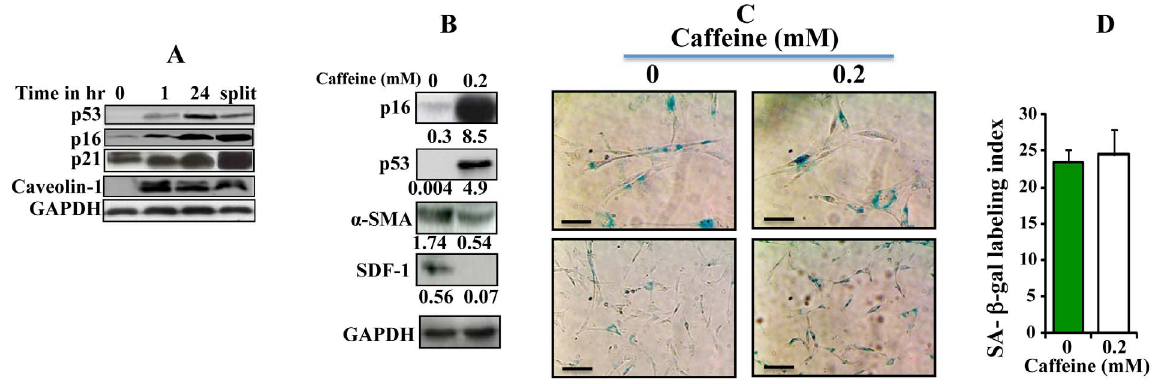
Figure 5. Caffeine effects are persistent. (A) Cells were either sham-treated (0) or challenged with caffeine (0.2 mM, for 1 hr), and then immediately harvested (1) or reincubated in caffeine-free medium for 24 hr, and then were either harvested (24) or split and reincubated for another 48 hr (split). Subsequently, cell lysates were prepared from all these cells and the levels of various proteins were assessed by immunoblotting. (B) Cells were either sham-treated or challenged with caffeine (0.2 mM) for 1 hr, and then reincubated in caffeine-free medium for 24 hr. Cell lysates were prepared and used for immunoblot analysis. The numbers below the bands represent fold of change as compared to the level at time 0, upon normalization against GAPDH used as internal control. (C) SA- b -gal activity was analyzed. Scale bars represent 50 m m. (D) Histogram shows SA- b -gal labeling index. Error bars represent means 6 S.D.